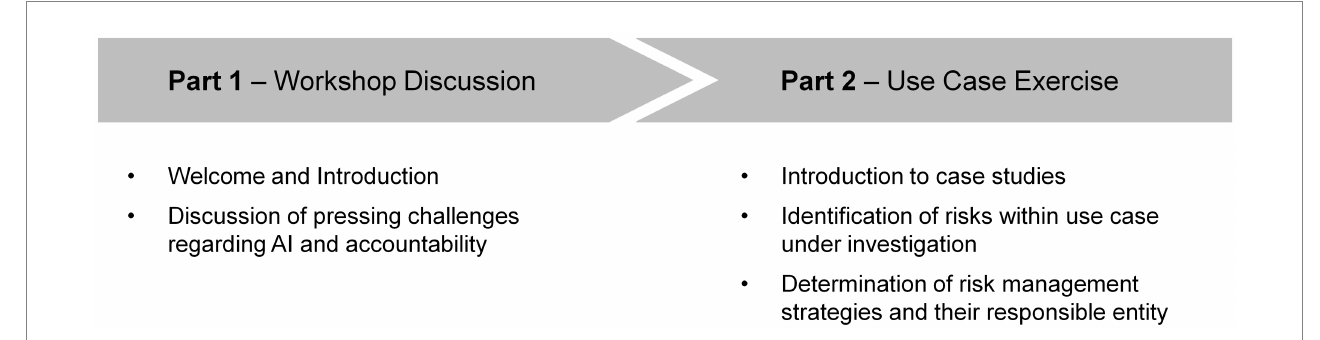
FIGURE 1 Overview of key considerations within and structure of this research.